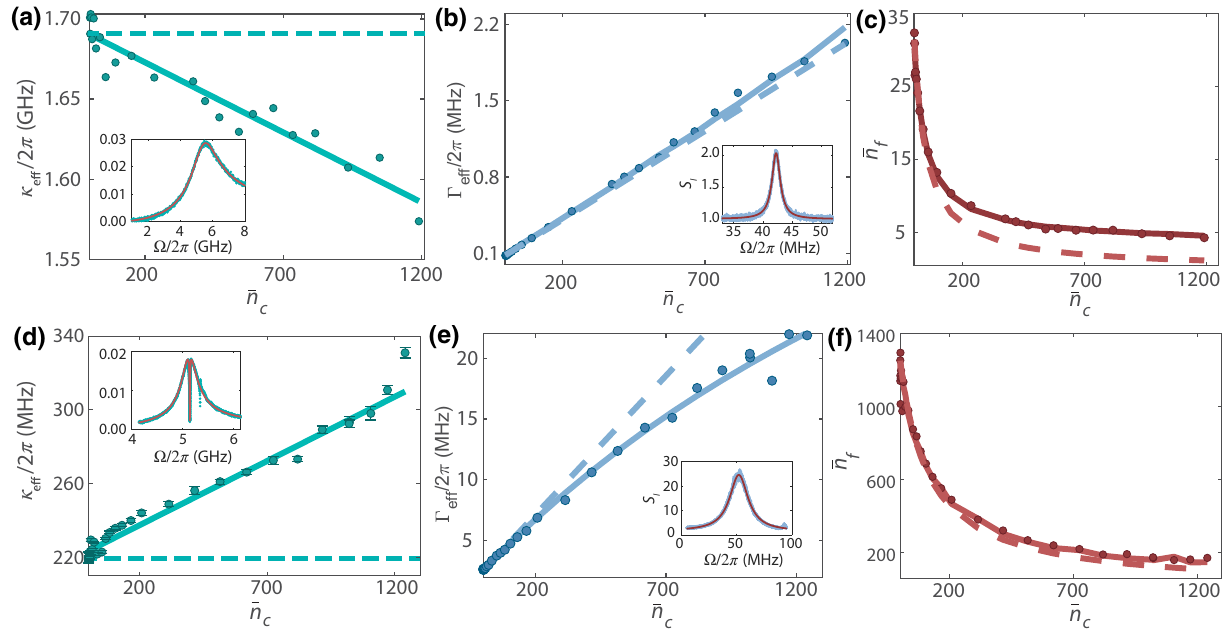
FIG. 2. Observation of dissipative feedback dynamics on cavity linewidth and optomechanical damping in optomechanical spec- troscopy of two sideband-cooled OMCs under different conditions. In (a)–(c), we show the results for an OMC of κ/ 2 π ∼ 1.7 GHz at approximately 8 K with a pressure approximately 0.5 mbar. (a) Fitted effective optical linewidth κ eff (green circles) versus intracavity photon number ¯ n c in the coherent cavity spectroscopy. The green curve shows a fitting curve incorporating the coherent dissipative dynamics, revealing a cavity linewidth that reduces with ¯ n c . The green dashed line shows the original cavity linewidth. The inset shows a typical fitting of coherent cavity response. (b) Fitted effective mechanical linewidth (cid:11) eff (blue circles) in the incoherent bal- anced heterodyne noise spectrum versus ¯ n c . Blue curve shows a fitting curve incorporating κ eff due to coherent dissipative dynamics. Blue dashed curve shows a theoretical plot without the dissipative absorption. The inset shows a typical fitting of incoherent noise spectrum. (c) Mean phonon occupancy ¯ n f (red circles) from the incoherent noise spectrum via mechanical noise thermometry versus ¯ n c . The calibration is done using mechanical noise thermometry anchored at the lowest photon number. The red curve shows a fitting curve incorporating the effective optical linewidth change and linear absorption heating. The red dashed curve shows a theoretical plot without dissipative absorption. In (d)–(f), we show the results from an OMC of κ/ 2 π approximately 220 MHz at room temperature and pressure, corresponding to the data in (a)–(c). Here an increase of κ eff versus ¯ n c is observed due to the dissipative feedback. In (e), the green dashed line shows the ideal theoretical effective mechanical linewidth without dissipative dynamics. In (d), the error bars